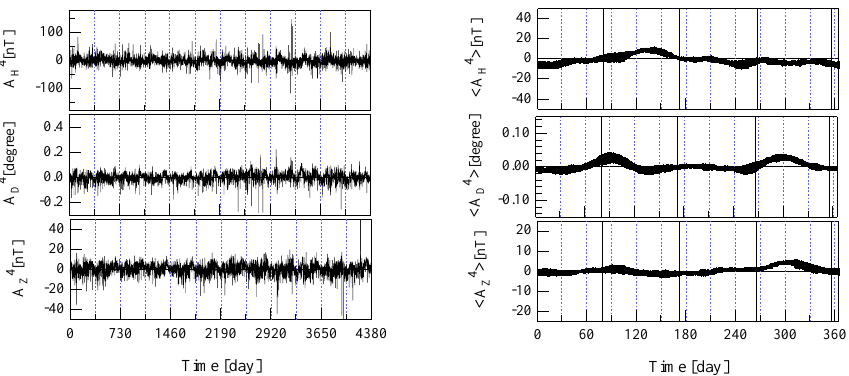
Fig. 11. The PCs associated with the EOFs reported in Fig. 10 for H, D and Z magnetic field elements (left panels) and the average annual behavior of PCs as evaluated applying the superposed epoch analysis (right panels). The vertical solid lines in right panels indicate the equinoxes and solstices.